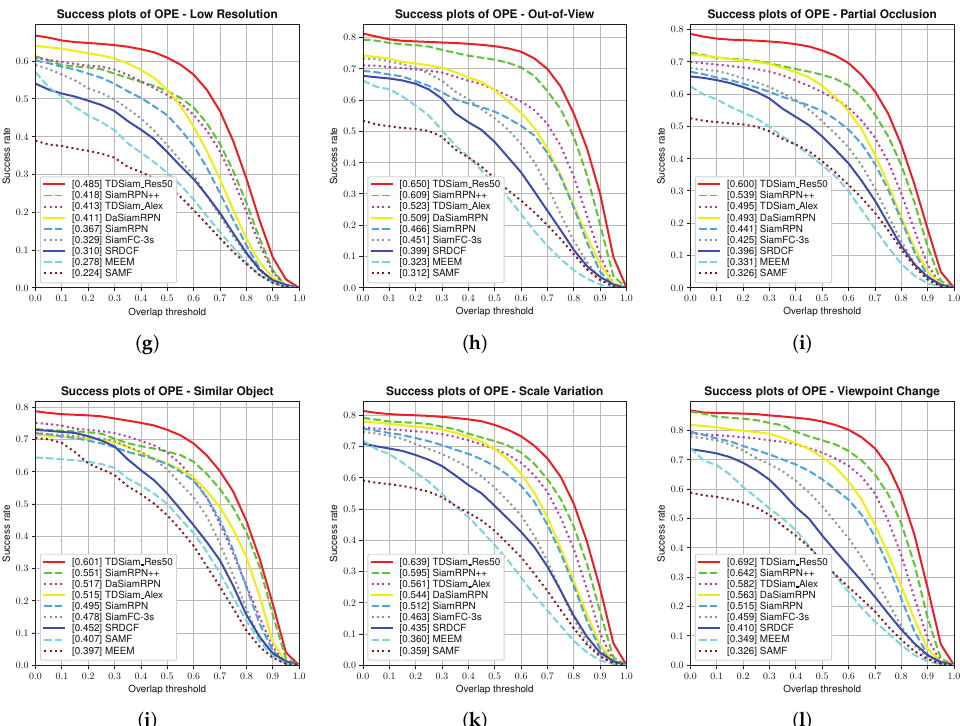
Figure 8. Success plots corresponding to some typical scenarios. The UAV123 dataset was used for the evaluation. ( a ) Aspect Ratio Change; ( b ) Background Clutter; ( c ) Camera Motion; ( d ) Fast Motion; ( e ) Full Occlusion; ( f ) Illumination Variation; ( g ) Low Resolution; ( h ) Out of View; ( i ) Partial Occlusion; ( j ) Similar Object; ( k ) Scale Variation; ( l ) Viewpoint